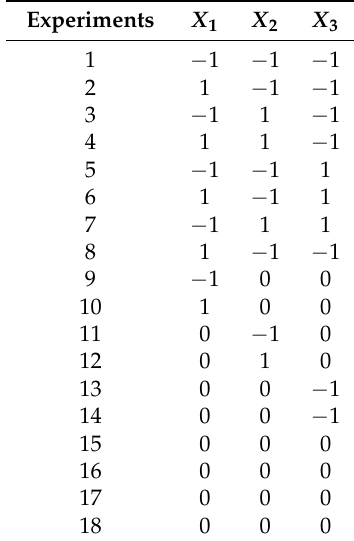
Table 2. Experimental